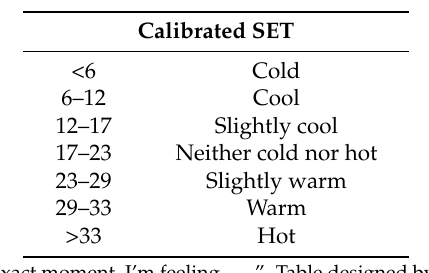
Table 3. Cutoff points for classes corresponding to the variable Response to Question 1 (*) of the questionnaire, calibrated for the